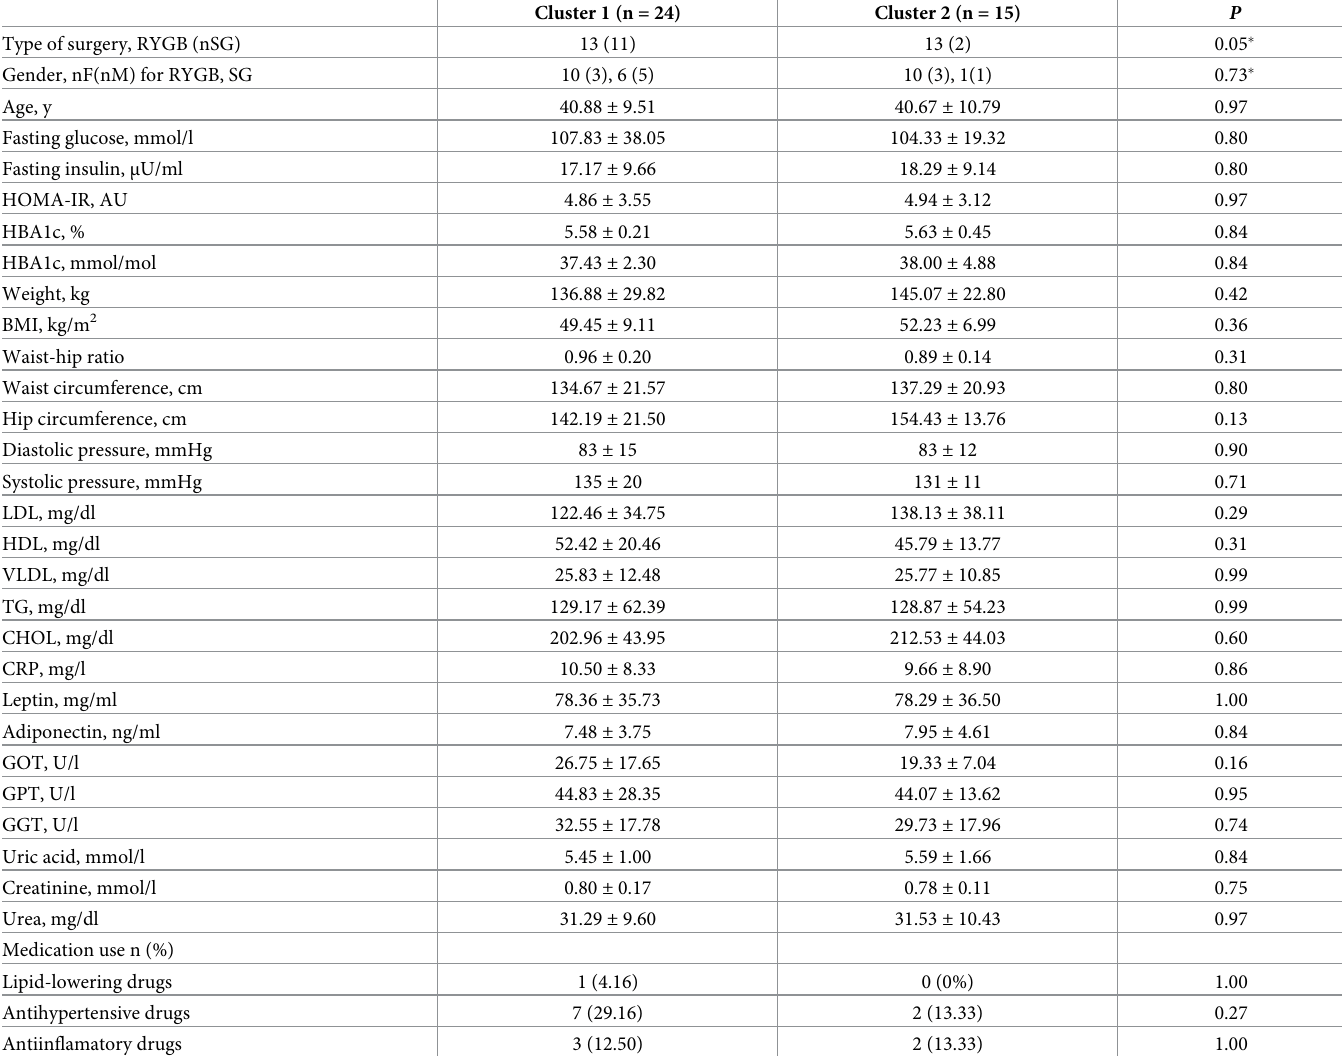
Table 2. Subjects’ demographic, anthropometric, biochemical and clinical characteristics before bariatric surgery a